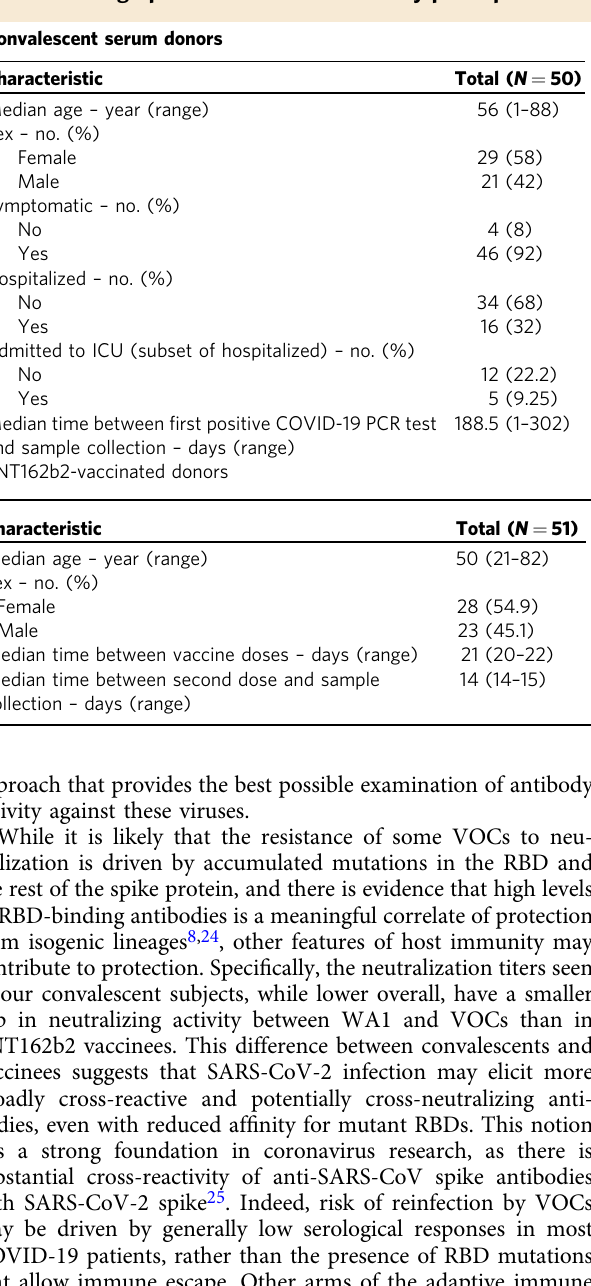
Table 1 Demographic characteristics of study